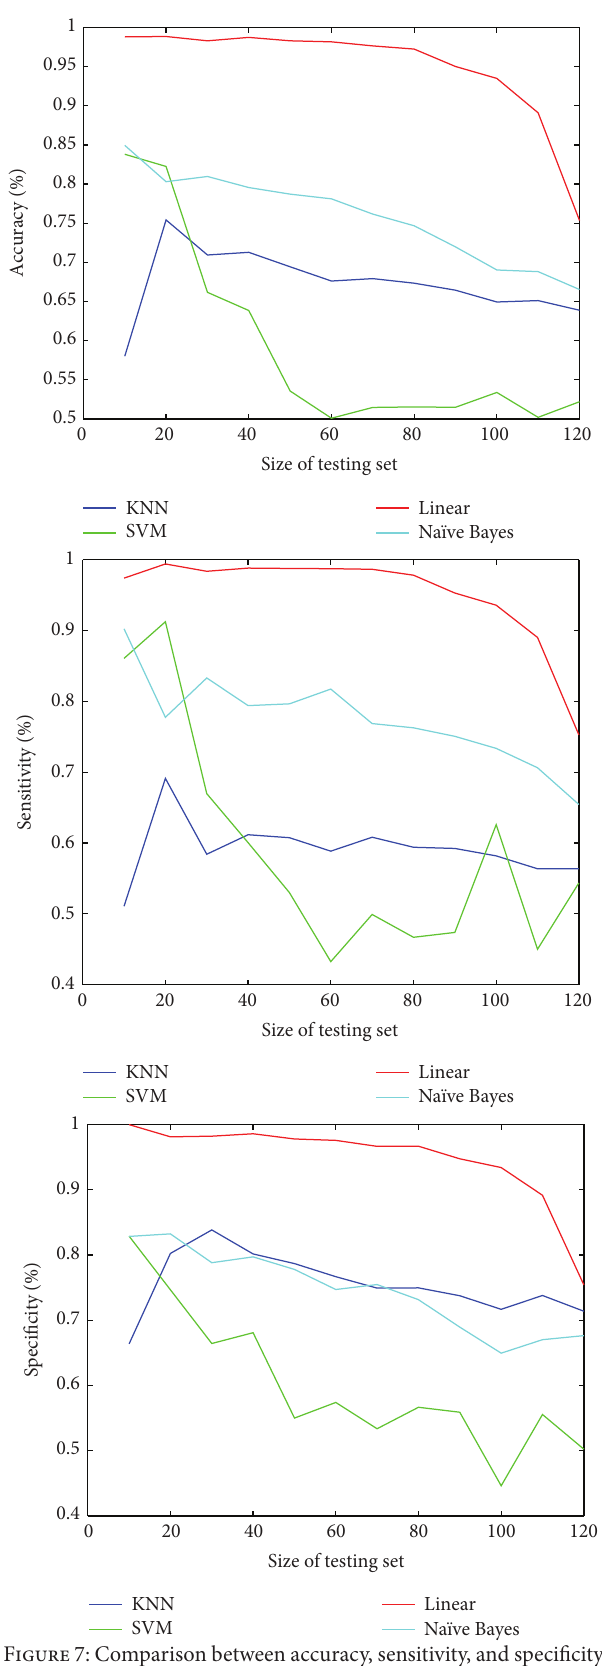
Figure 7: Comparison between accuracy, sensitivity, and specificity for the four classifiers with changing size of testing set.